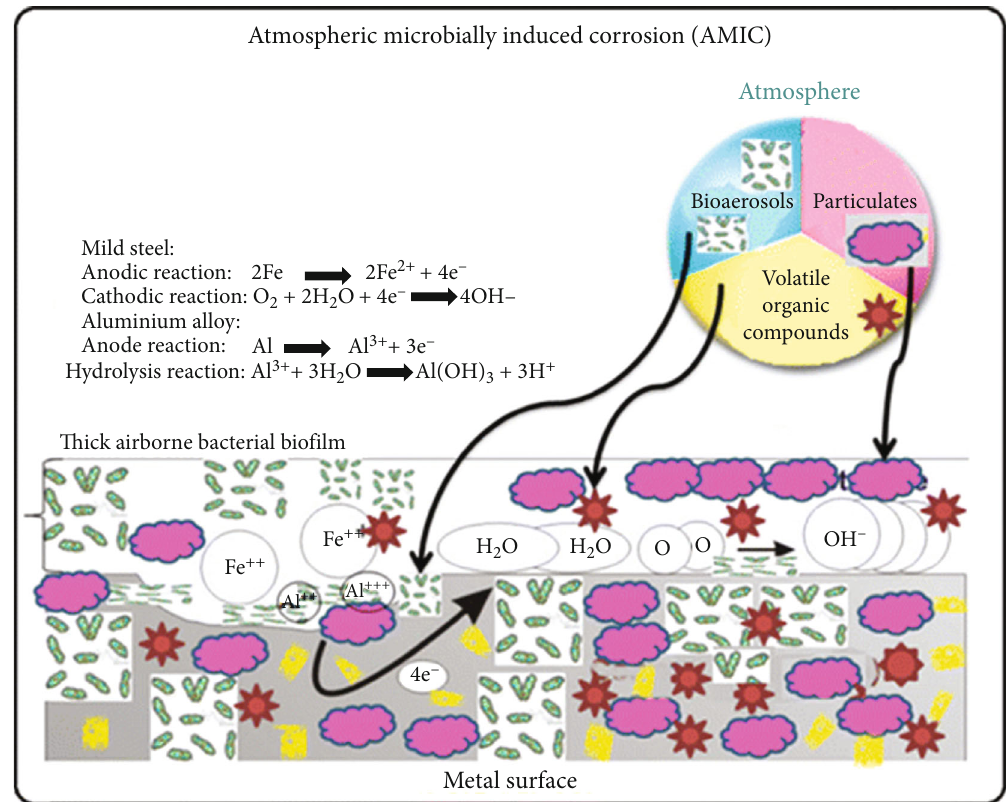
Figure 7: Atmospheric microbially induced corrosion